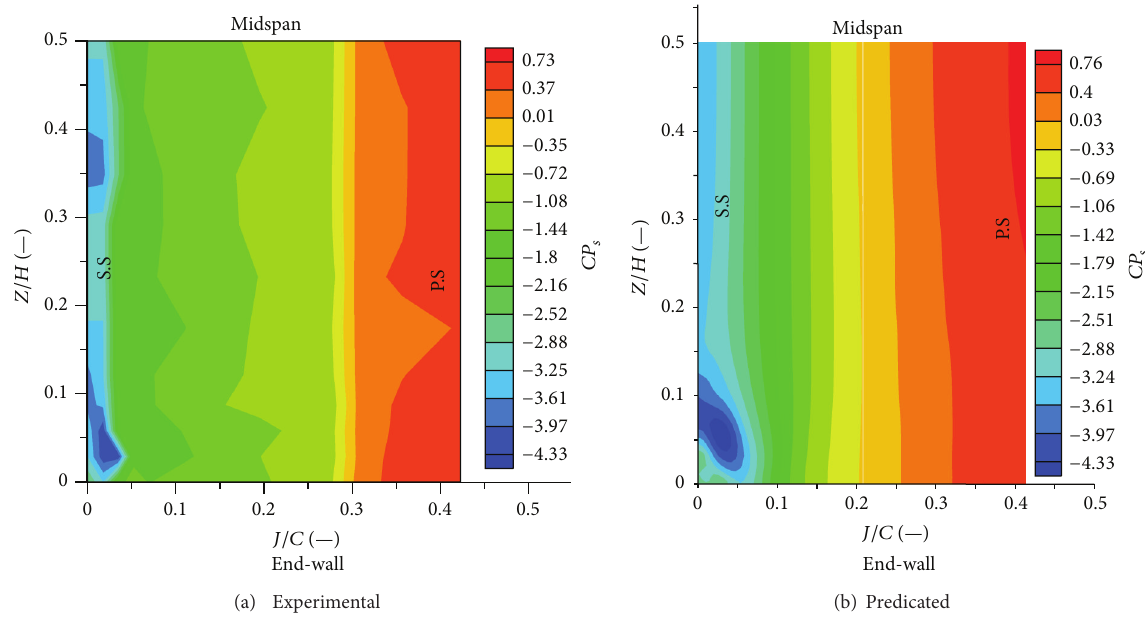
Figure 11: Static pressure coefficient on plane 1 at 𝑆/𝐶 = 0.63 .